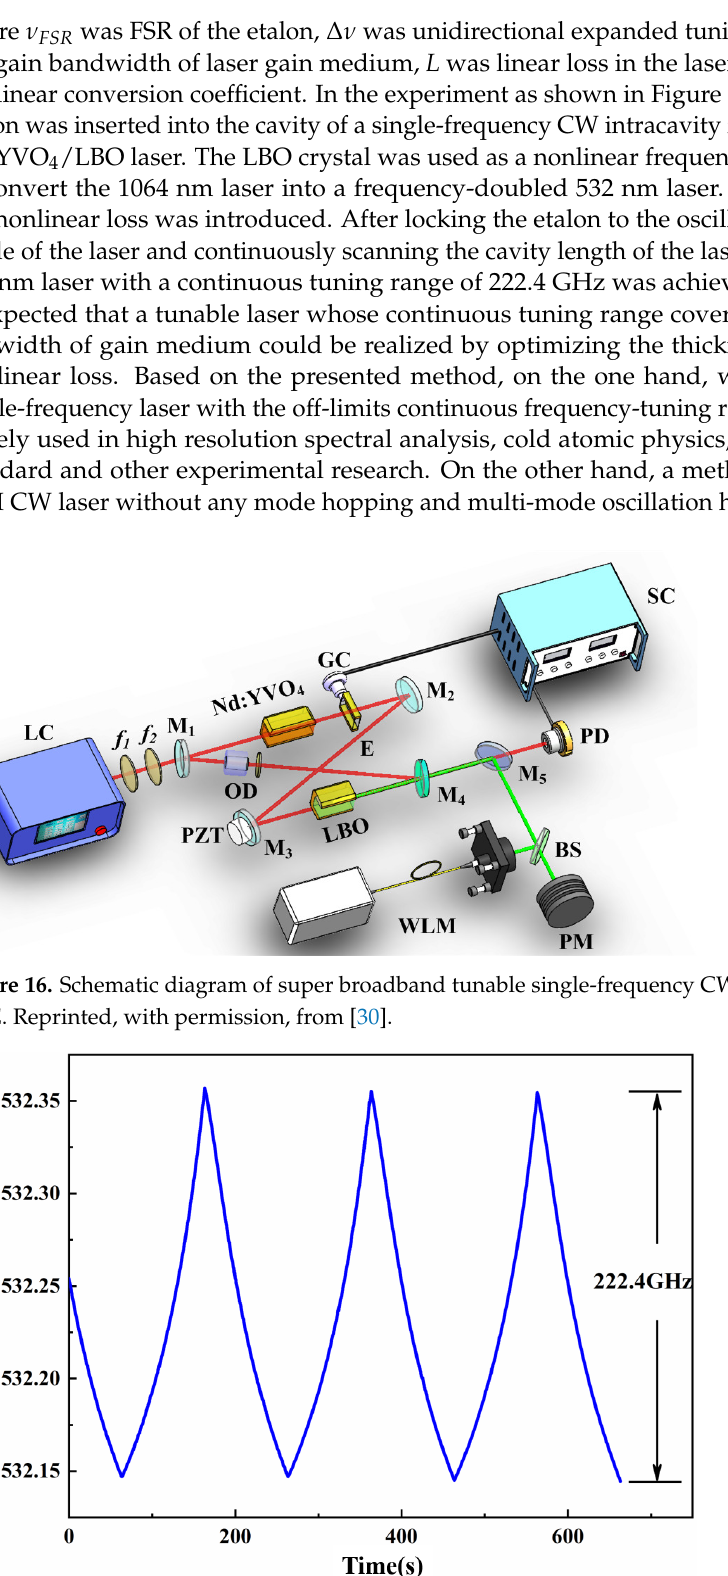
Figure 17. The tuning range of 532 nm single-frequency tunable